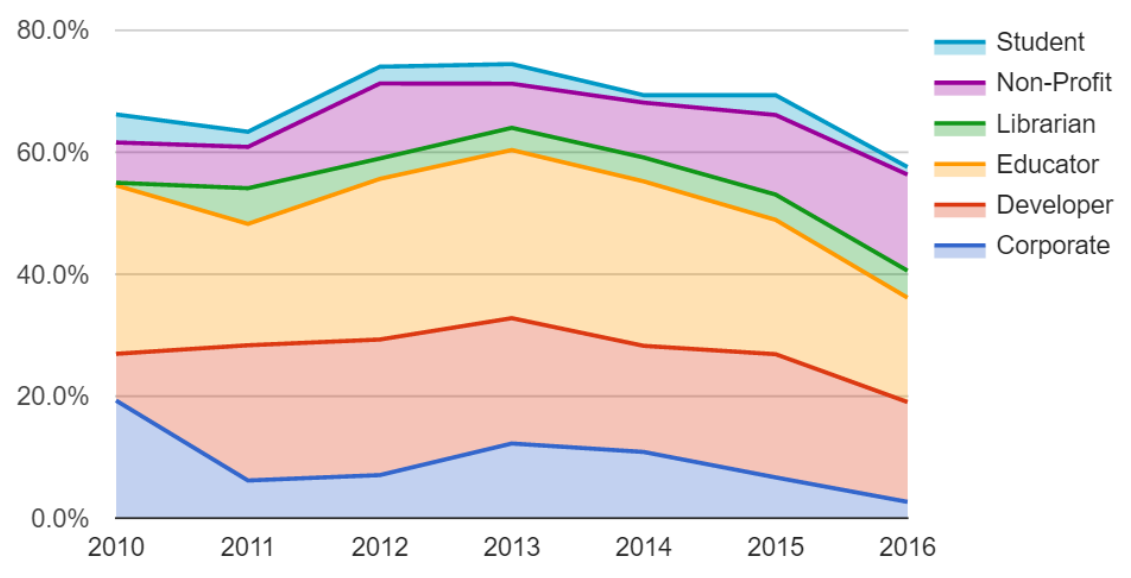
Figure 4. Individual account tweets by year and